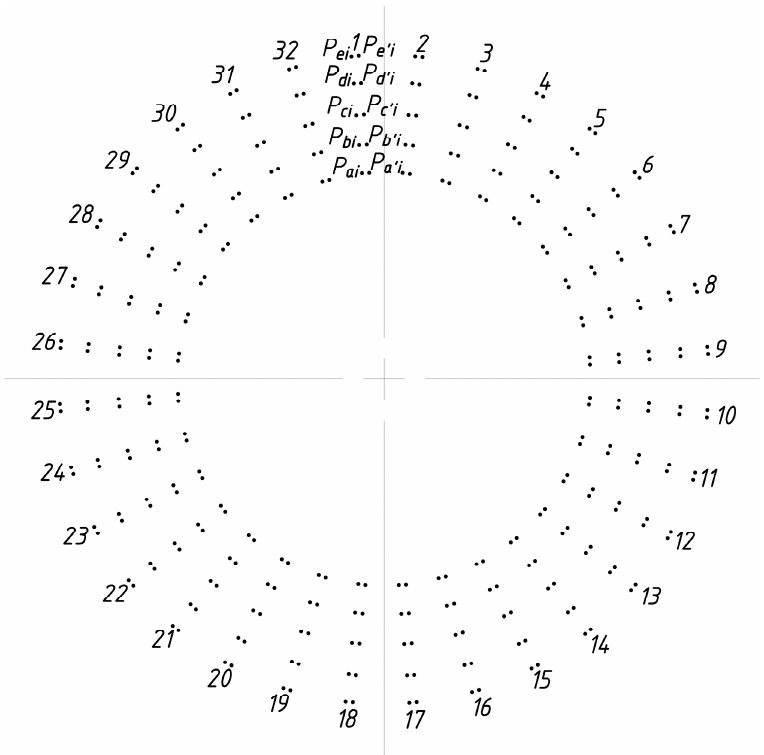
Figure 5. Coordinates of the intersection points between the detected circle and the tooth tip ridge line after